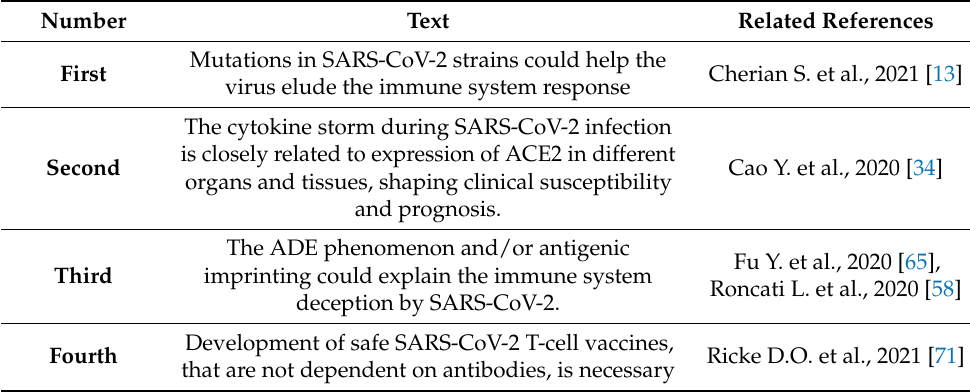
Table 2. Take home